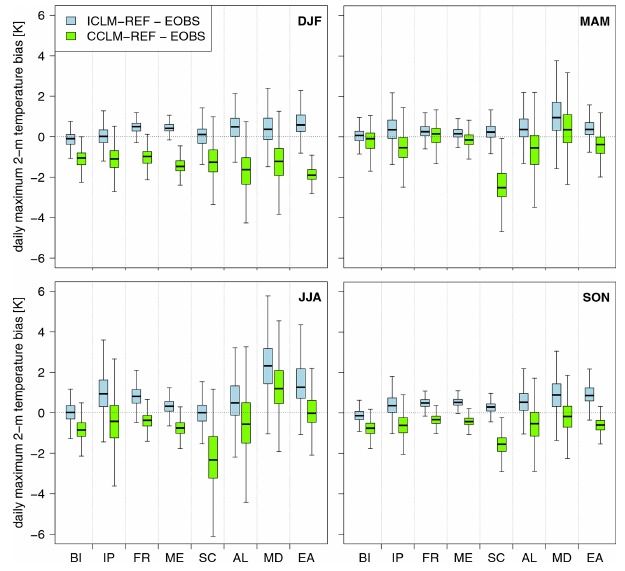
Figure 6. Same as Fig. 5 but for daily maximum 2m temperature.